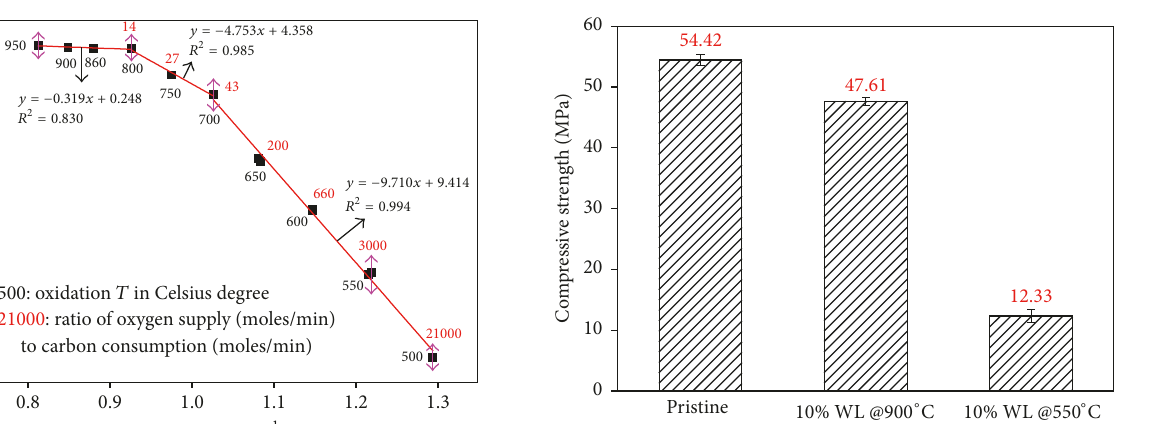
Figure 4: Average values for compressive strength of MG specimens oxidized to ∼ 10% weight loss at 550 and 900 ∘